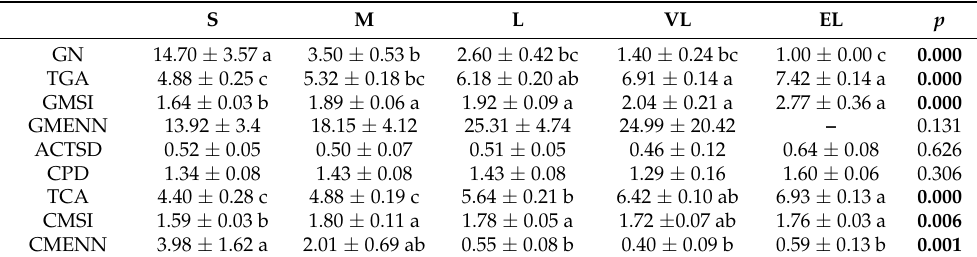
Table 2. Differences of gap characteristics, color-leaved tree species diversity, and color-leaved patch structure attributes in five gap